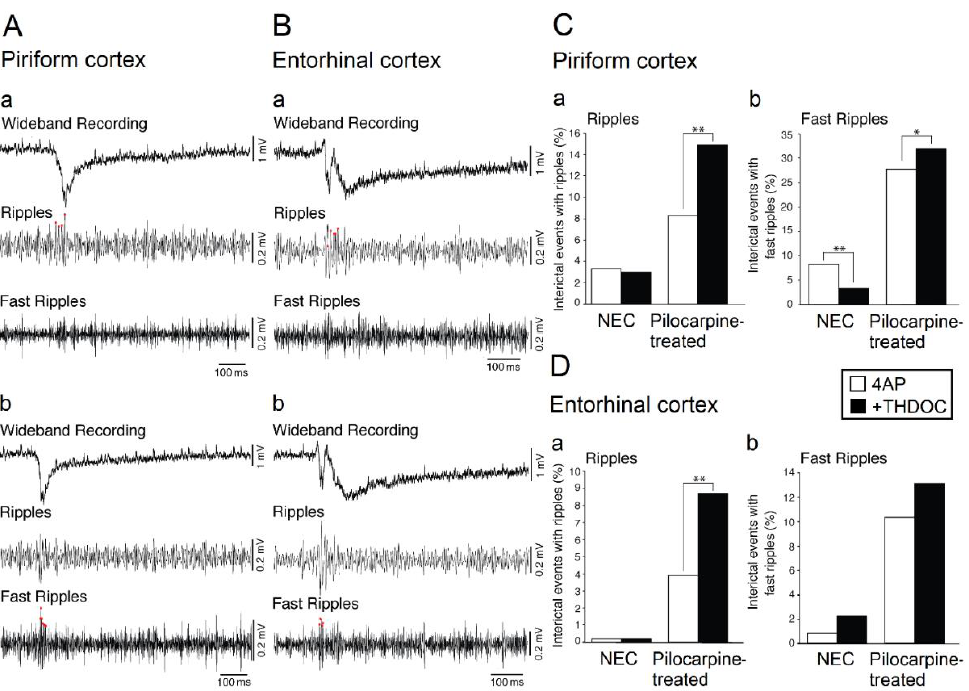
Figure 3. HFOs associated with 4AP-induced interictal discharges occurring in the piriform ( A ) and entorhinal cortex ( B ); field potential recordings showing interictal events co-occurring with ripples and fast ripples are shown in panels ( a ) and ( b ), respectively. ( C ) and ( D ): Quantification of the effects induced by THDOC on the ripples and fast ripples associated with 4AP-induced interictal events recorded from the piriform and entorhinal cortex of brain slices that were obtained from NEC and pilocarpine-treated rats. Note that THDOC increases the association of ripples with the interictal discharges occurring in both the piriform and entorhinal cortex of epileptic animals; THDOC also decreases and increases fast ripple occurrence in the piriform cortex of NEC and epileptic brain slices, respectively, but does not induce any significant change in fast ripples recorded from the entorhinal cortex. * indicates p < 0.05; ** indicates p < 0.01. Panels shown in this figure are modified from the study by Shiri et al. [17].